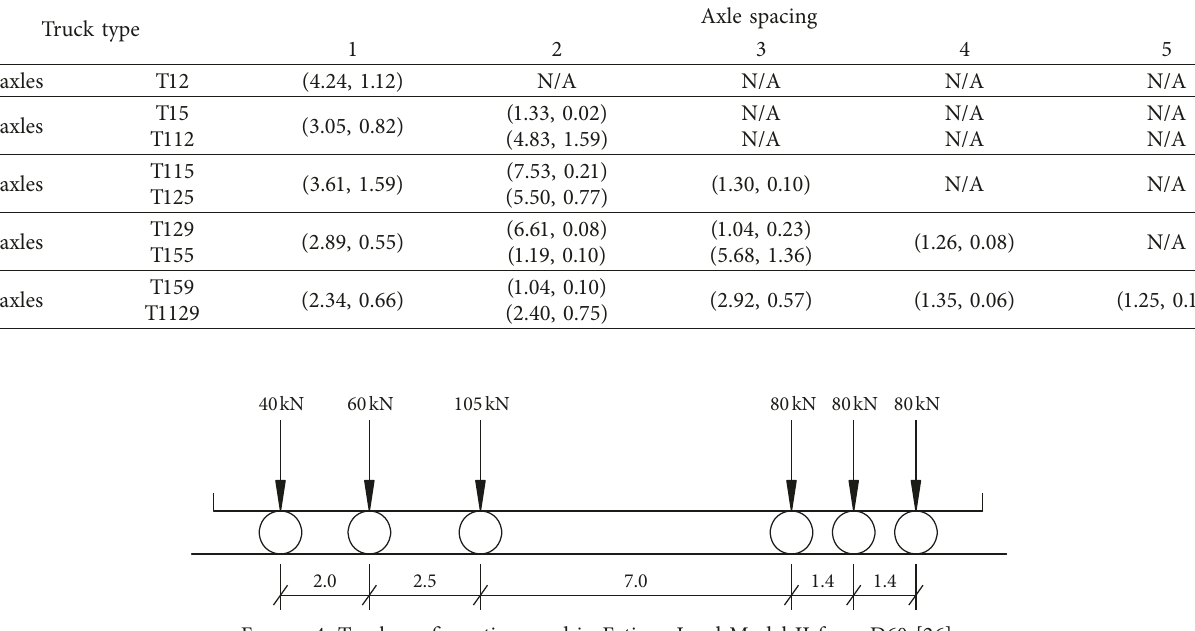
Figure 4: Truck configuration used in Fatigue Load Model II from D60